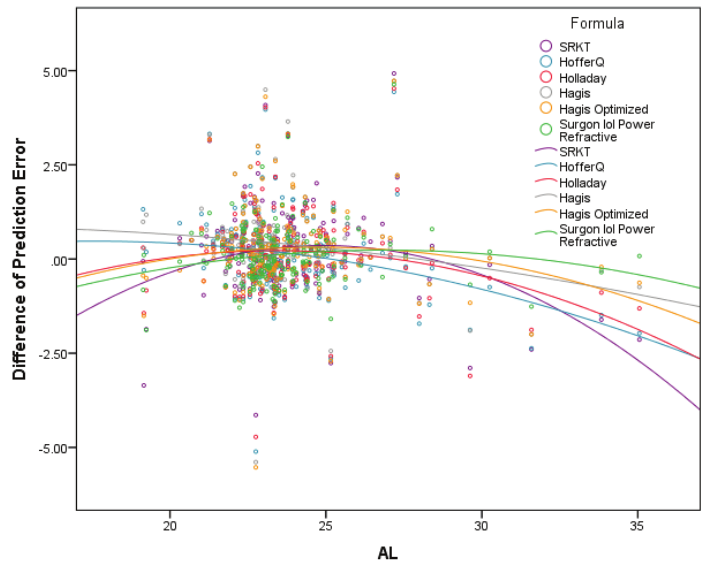
Figure 5. Distribution of absolute prediction errors based on axial length for each formula. The OKULIX and Haigis formulas had the lowest magnitude of change in the prediction error in different ranges of axial